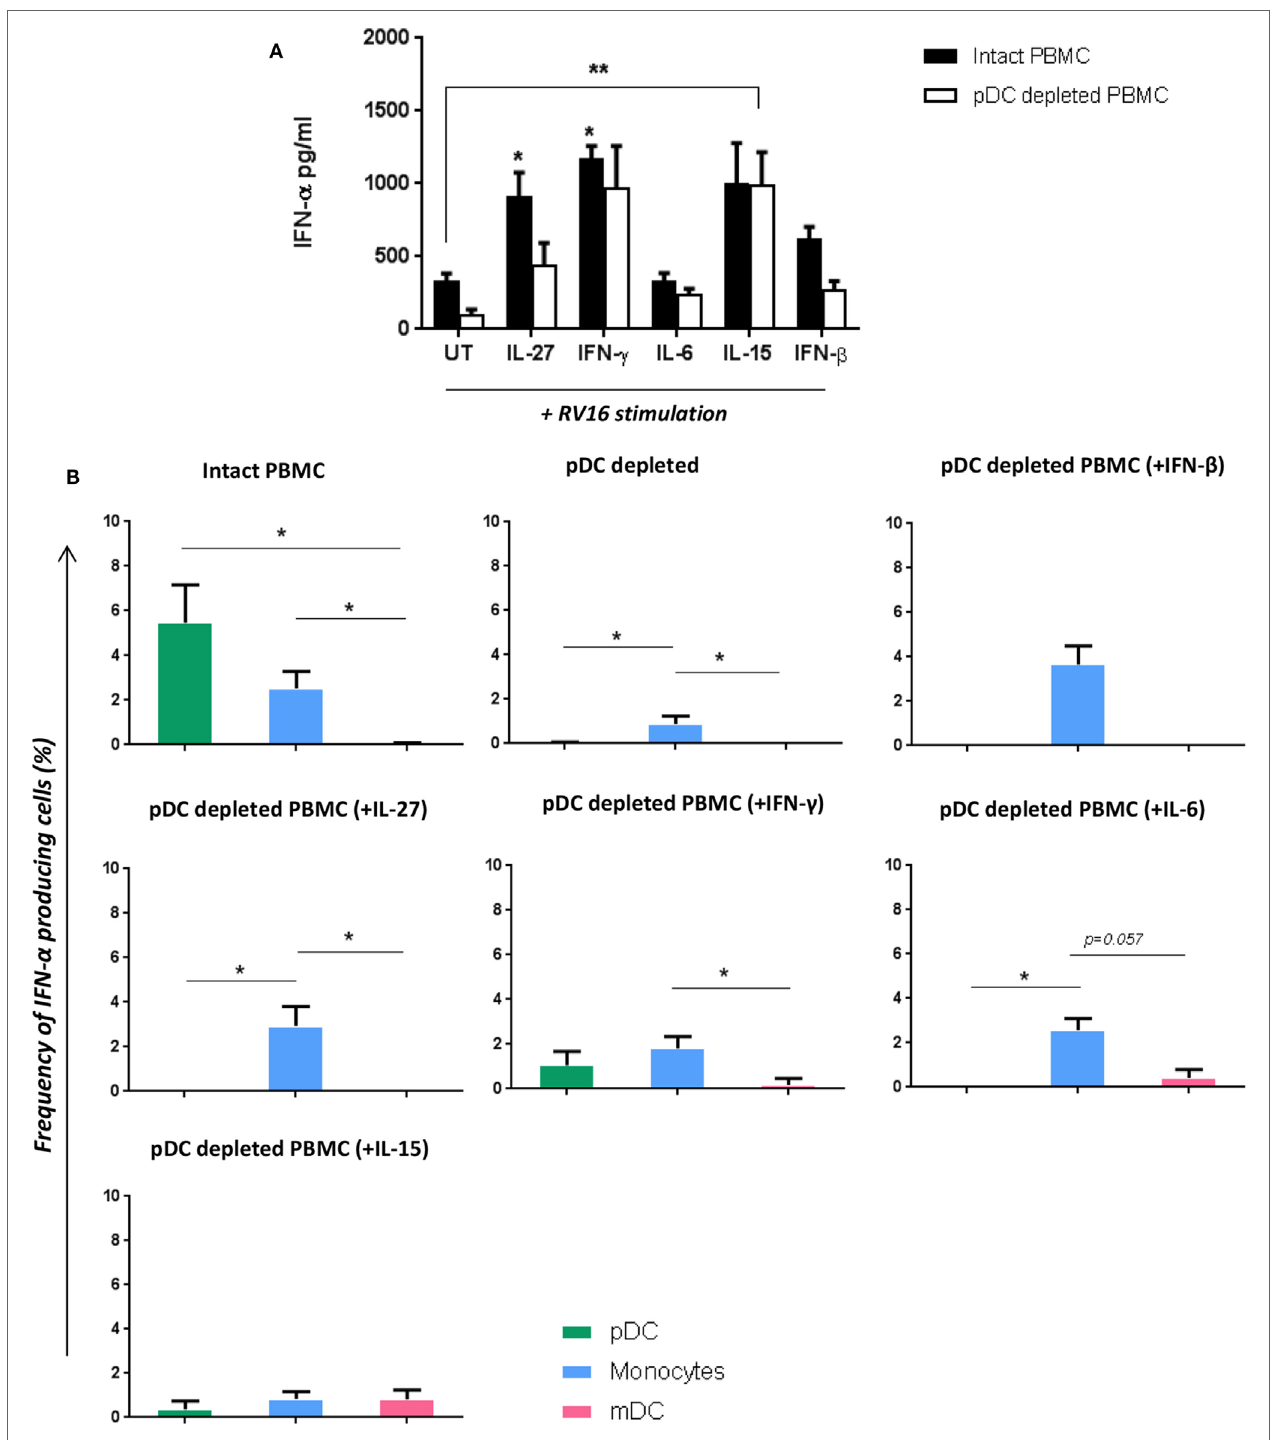
FigUre 6 | Addition of certain cytokines to plasmacytoid dendritic cell (pDC)-depleted cultures successfully rescues the interferon (IFN)- α response. Intact peripheral blood mononuclear cell (PBMC) (black bar) and pDC-depleted PBMC (white bar) were precultured with IL-27, IFN- γ , IL-6, IL-15, or IFN- β recombinant protein or with media only for 4 h at 37°C. All samples were subsequently stimulated with human rhinoviruses strain 16 (RV16) [multiplicity of infection (MOI) = 1] for a further 20 h. IFN- α protein was measured by ELISA ( *p < 0.05; **p < 0.01; UT, untreated.) (a) , and IFN- α producing cell subsets were measured by Flow Cytometry ( *p < 0.05) (B) . Data represent mean ± SD.